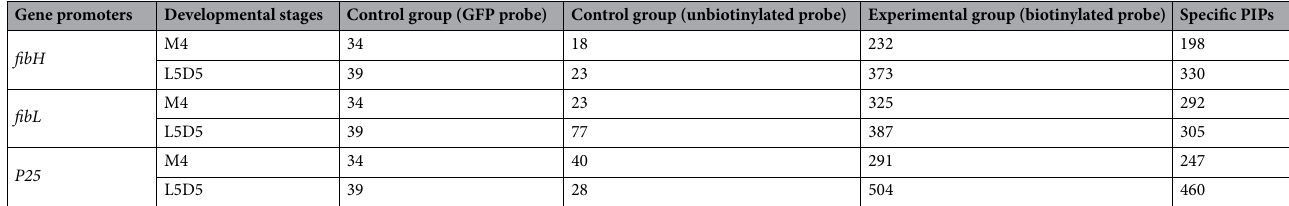
Table 1. Summary of candidate PIPs identified by HPLC–MS.